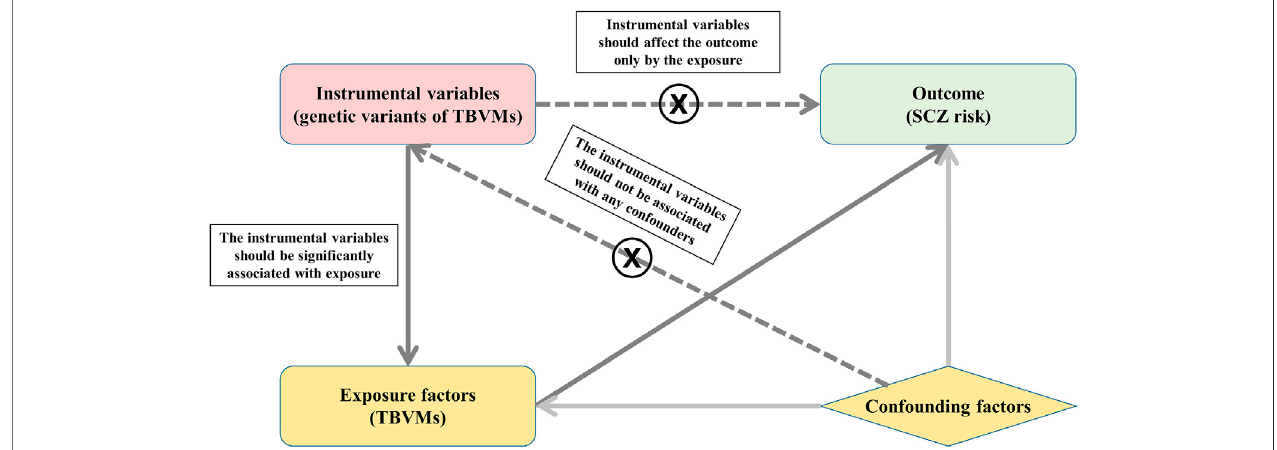
FIGURE 1 | Study design based on MR principal assumptions. In this study, MR is based on the publicly available GWAS summary datasets in TBVMs and SCZ. Speci fi cally, the genetic variants that are signi fi cantly associated with TBVMs were used as the instrumental variables to examine the causal in fl uence of TBVMs on SCZ risk. Abbreviations: SCZ, Schizophrenia; TBVMs, total brain volumetric